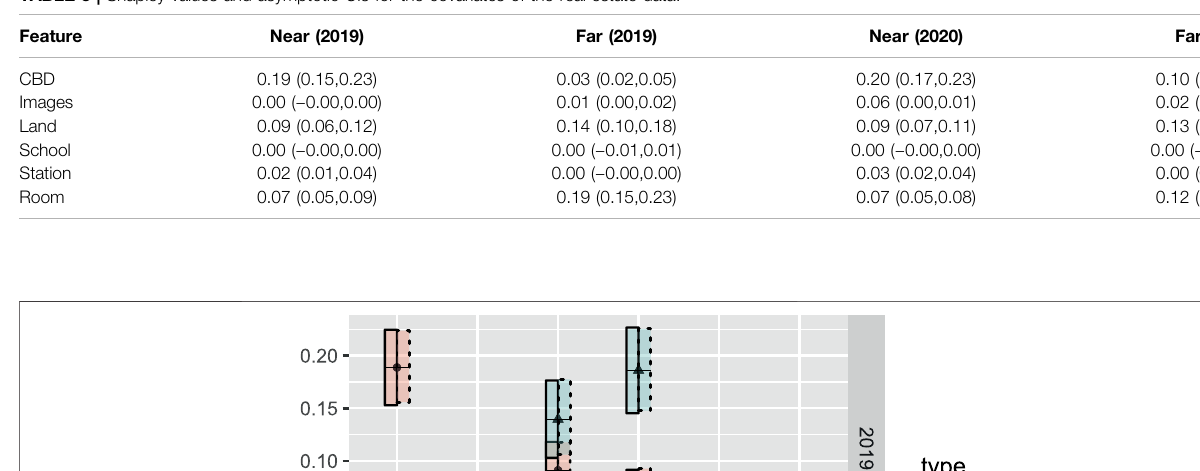
Frontiers in Applied Mathematics and Statistics |